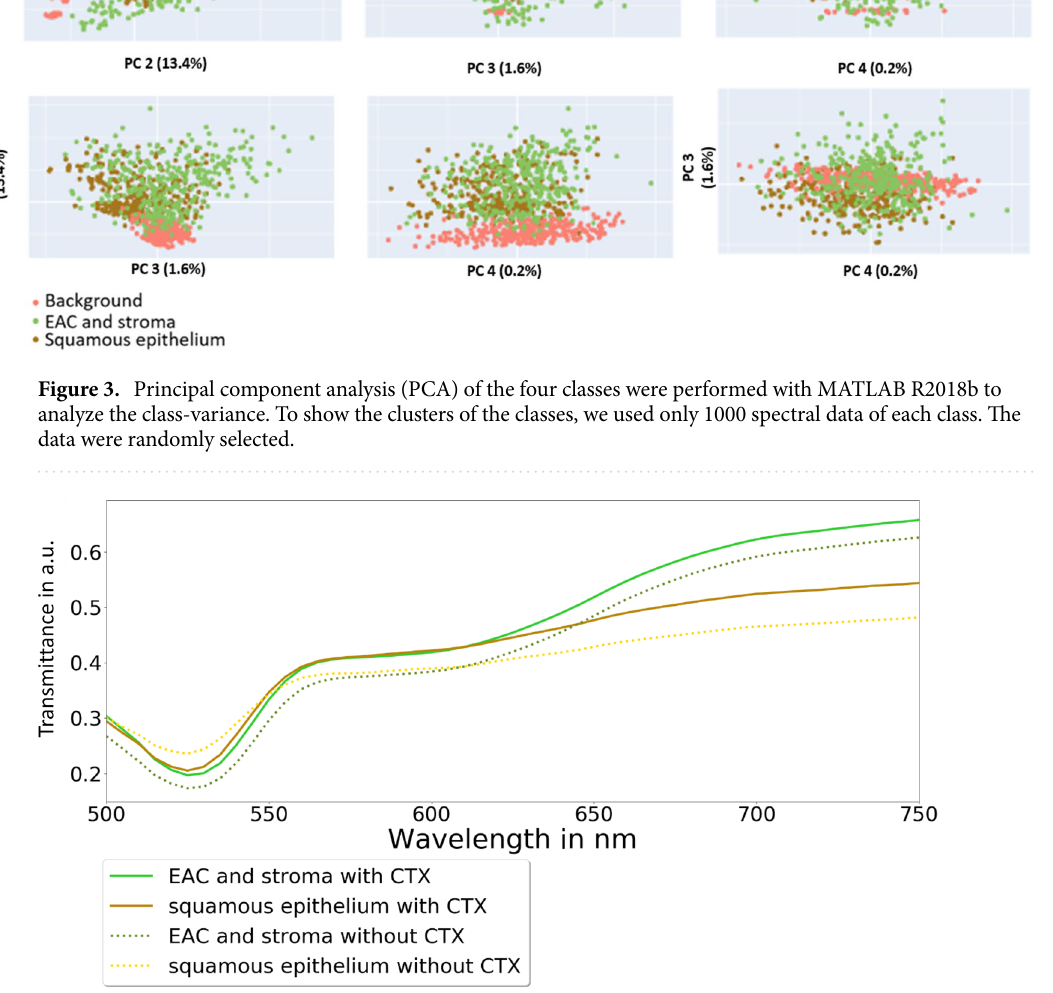
Figure 4. The mean transmittance of the spectra values of patients with and without neoadjuvant chemotherapy (CTx) is shown. The EAC and stroma without CTx versus squamous epithelium without CTx showed a high difference in the area from 500 to 570 nm and from 650 to 750 nm. The EAC and stroma with CTx versus squamous epithelium with CTx showed a high difference only in the area from 650 to 750